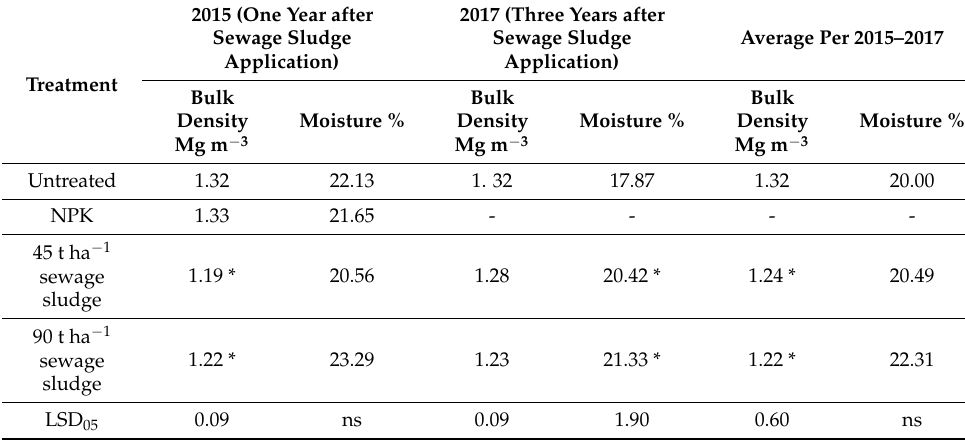
Table 4. Soil bulk density and moisture in relation to fertilization type at the common osier growing site in 2015 and 2017.